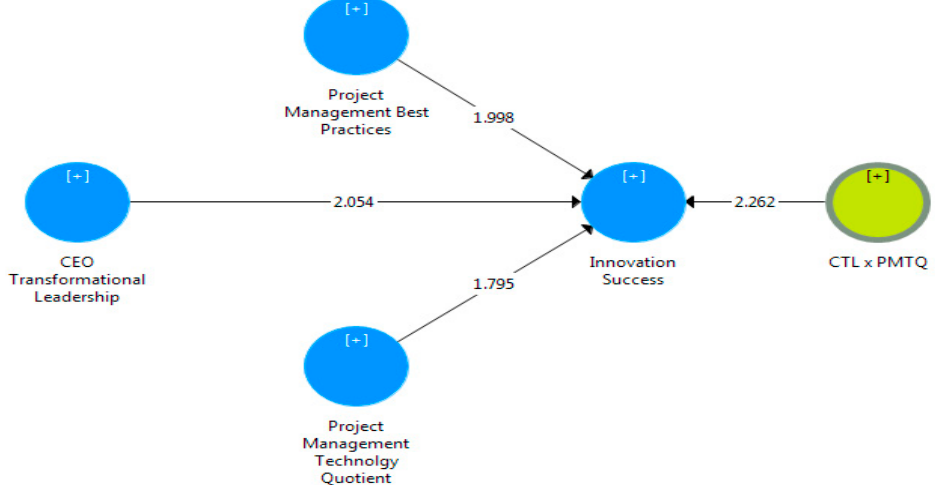
Figure 4. Moderating effects of PMTQ.